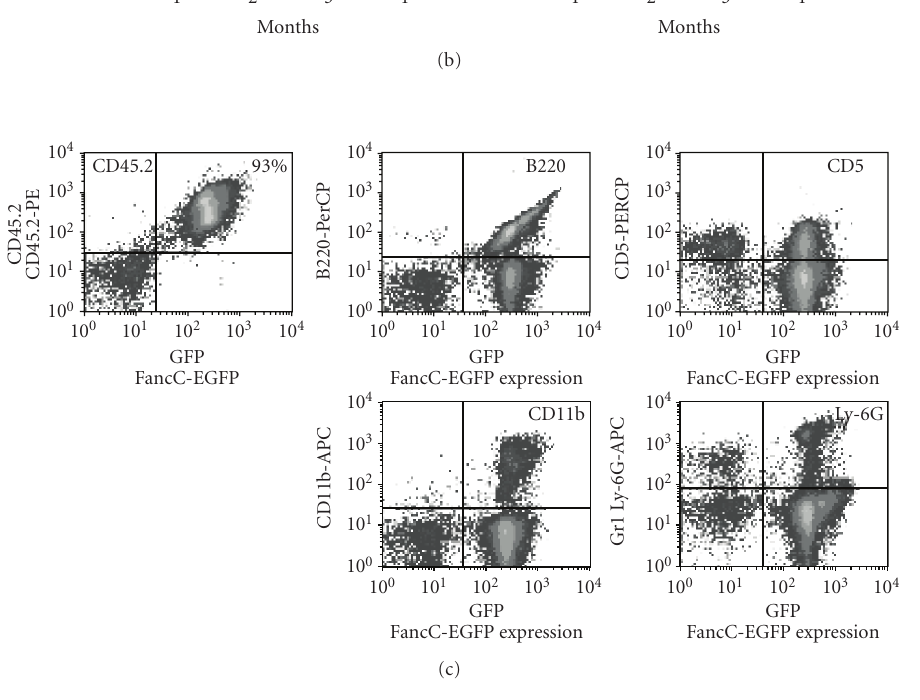
Figure 5: Reconstitution ability of intrafemorally transduced HSC following transplants. Percent donor chimerism (CD45.2-positive cells) in peripheral blood cells from recipients transplanted with total BM from (a) IF-injected WT, FancC − / − , or FancA − / − mice and (b) from WT or FancC − / − mice that received chronic MMC treatments at 7 weeks following IF-injection as a function of time. Each dot represents donor chimerism of an individual recipient. Horizontal line: mean value. (c) Representative cytometric profiles of FancC-EGFP expression in peripheral blood cell lineages from transplanted mice at 3 months following transplantation with BM cells from FancC − / − IF-injected